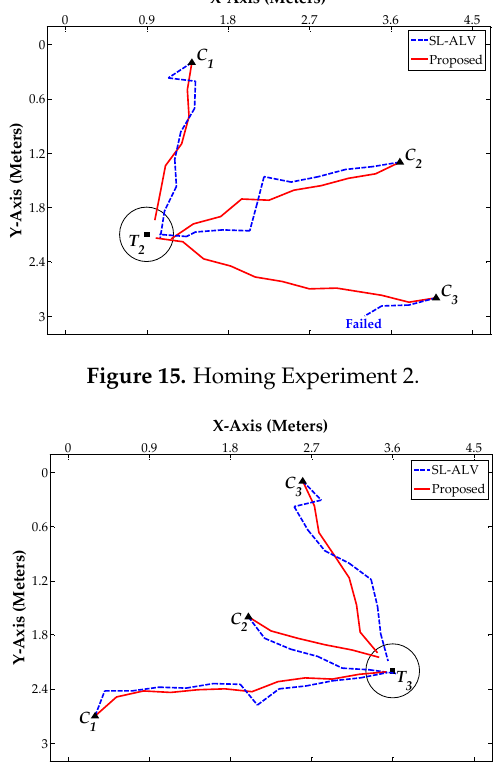
Figure 14. Homing Experiment 1. The target area is denoted as a circle centered on a square block. The three starting location C 1 , C 2 and C 3 are marked as triangular blocks. Blue dashed lines denote the homing trajectories generated by SL-ALV. Red solid lines denote the homing trajectories generated by our proposed strategies. Table 4. Associated results of homing experiment 1.